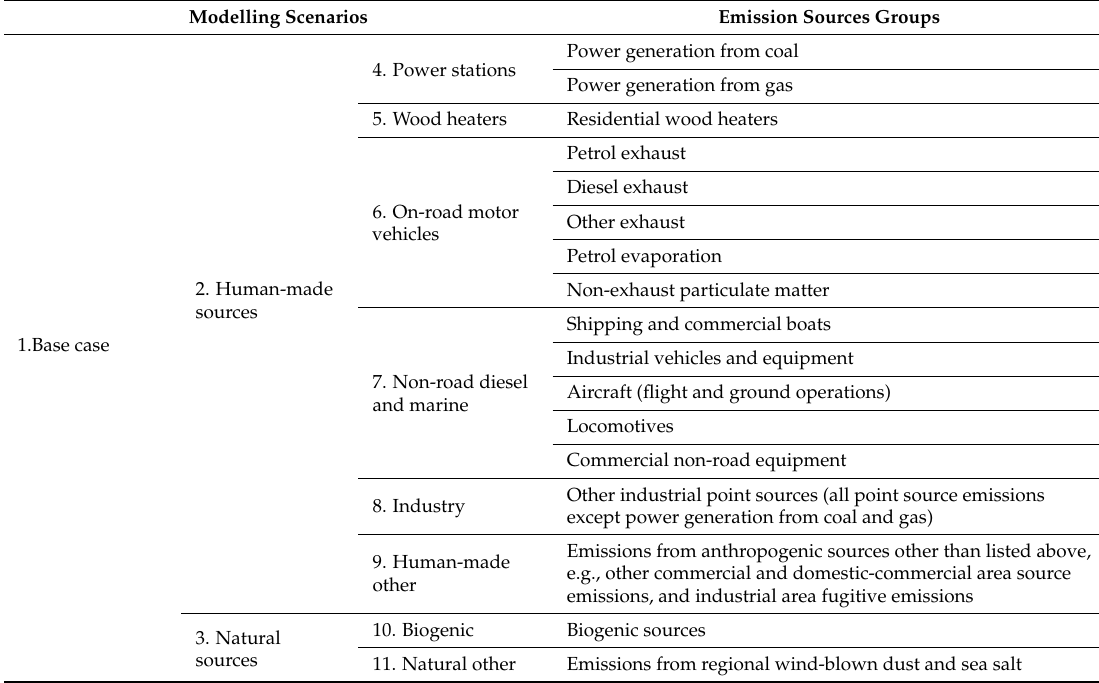
Table 1. Modelling scenarios for the 2008 calendar